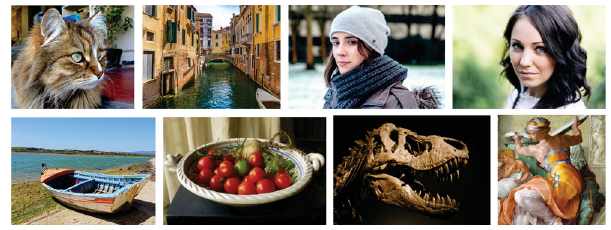
Fig. 20 Input images used in Figs. 9, 10, 13, 14, and